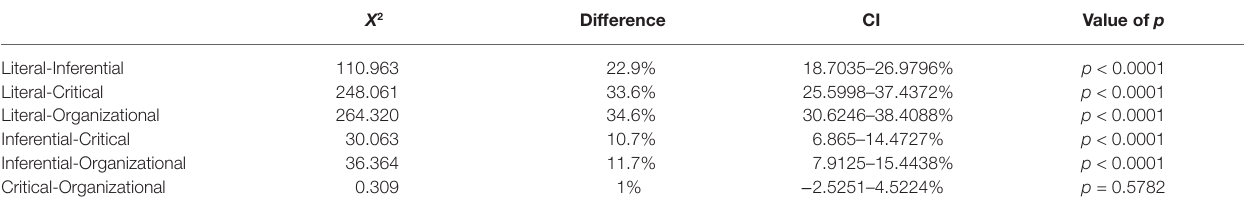
TABLE 3 | Results of effect size